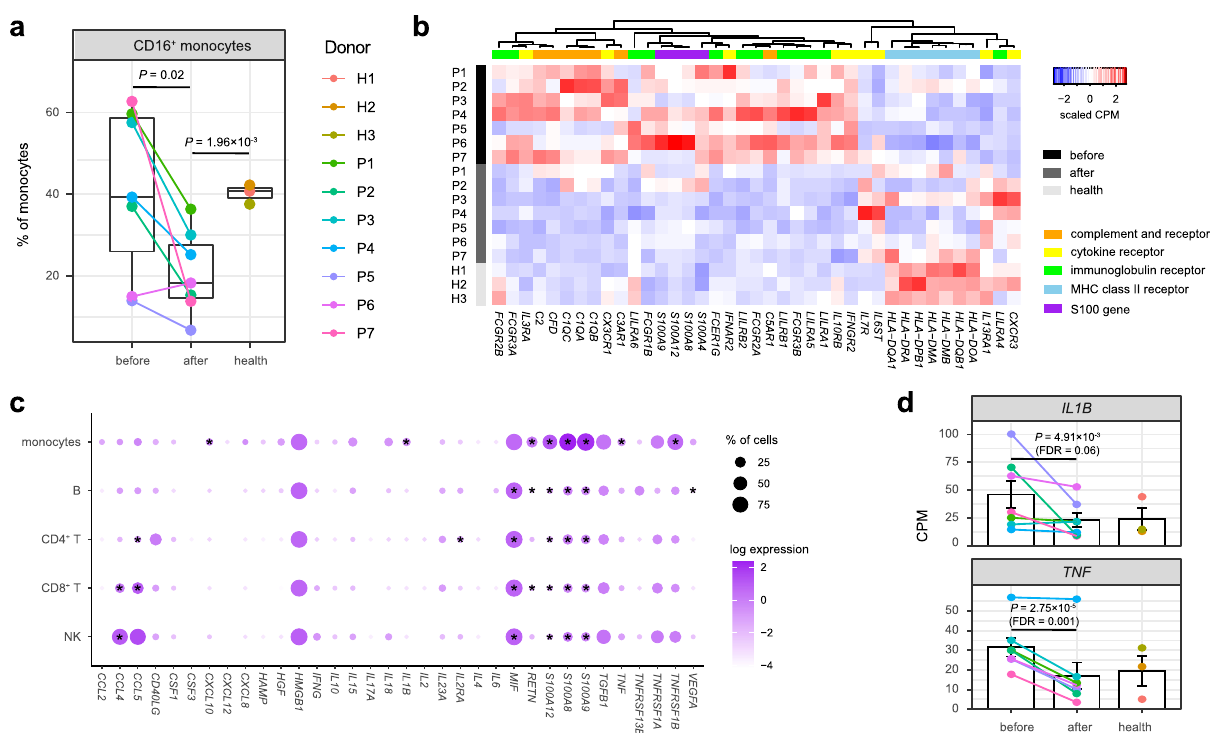
Fig. 3 Characterization of monocytes and transcriptional patterns. a Percentage of CD16 + monocytes across conditions recovered by scRNA-seq (KD patients n = 7, healthy controls n = 3). The middle line of the boxplot is the median, the lower and upper hinges correspond to the fi rst and third quartiles, and the whiskers extend from the hinge to the farthest data point within a maximum of 1.5× interquartile range. The samples are colored according to donors. P -values are calculated by using the two-sided t -test. b Heat map of DEGs with functional enrichment in monocytes. Gene expression on the sample level is measured by the counts per million mapped reads (CPM), which is then scaled across samples. c Expression patterns of cytokines reported to be elevated in KD. The dot plot depicts average expression level and percentage of cells expressing the cytokine genes across PBMC populations. Cytokine genes with higher expression in pre-treatment patients than post-treatment patients or healthy controls (nominal P -value < 0.05 with DESeq2 31 , two-sided) are marked with stars. d Expression level of IL1B and TNF in monocytes across conditions (KD patients n = 7, healthy controls n = 3). The bar plot depicts mean CPM and standard error of the mean. The samples are in the same colors as a . P -values and FDRs are calculated with DESeq2 31 (two- sided). Source data are provided in the Source Data fi